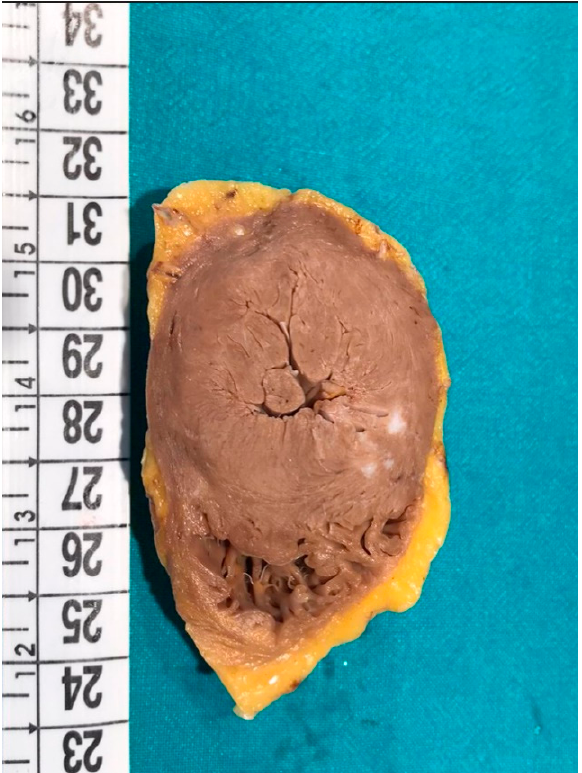
Figure 2. Macroscopic transversal section of the heart of a 48-year-old man affected by hypertrophic cardiomyopathy (HCM) (the same case of Figure 1). Concentric hypertrophy is clearly visible.